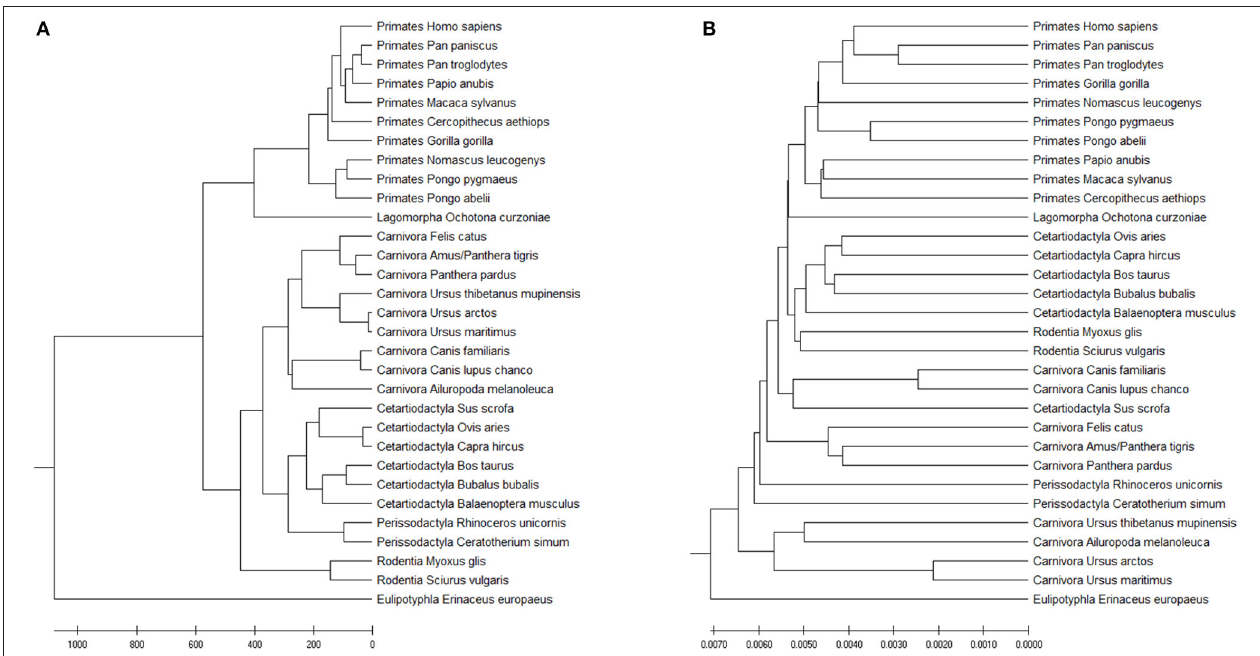
FIGURE 7 | (A) The phylogenetic UPGMA tree using ANV method on mammals mtDNA dataset. (B) The phylogenetic UPGMA tree using FFP ( k-mer ) method when K = 8 on mammals mtDNA dataset.